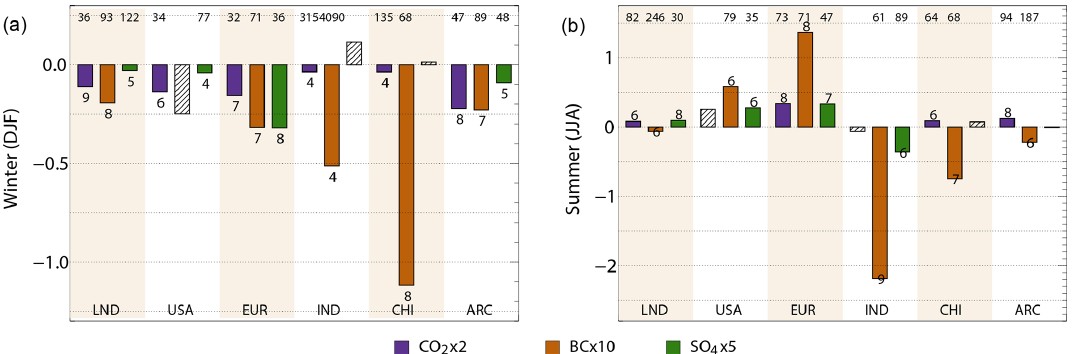
Figure 4. Multimodel median change in DTR for the different drivers and seasons, normalized by the global mean temperature change [KK − 1 ]. Cases for which 80% of models with data have DTR changes of the same sign are marked with colors, whereas hatched bars indicate larger model disagreement. The numbers below with the colored bars show the number of models for which the change is statistically significant (Student’s t test p value of less than 0.05). The coefficients of variation (standard deviation divided by mean) [%] are shown as numbers on the